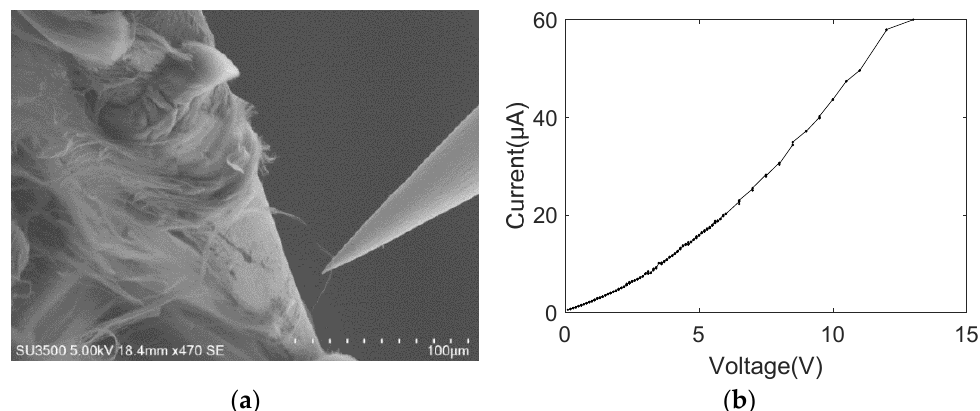
Figure 7. MWCNT bundle contacting with one tungsten probe ( a ) SEM image; ( b ) current–voltage curve.